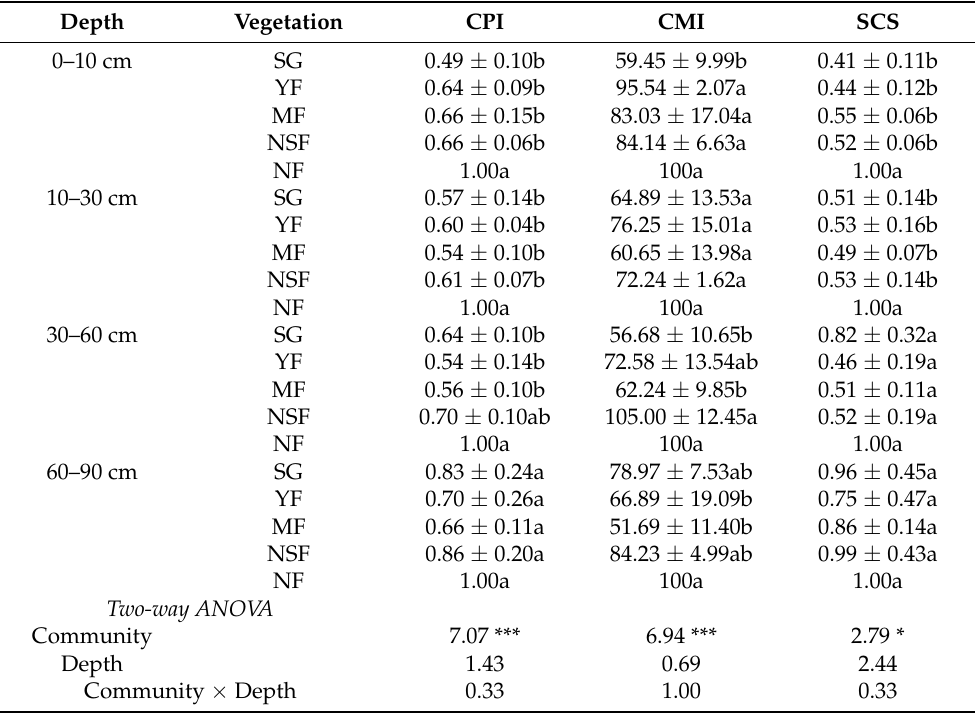
Table A3. Soil CPI, CMI, and SCS in different soil depths in five vegetation